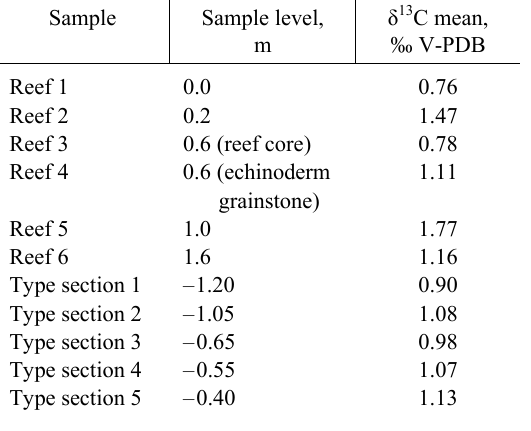
Table 1. δ 13 C values of the Saku quarry type section (positions refer to the 2 m level of Pılma et al. 1988), from a ditch in the same quarry and from the section Saku reef 1 (positions measured from reef top)